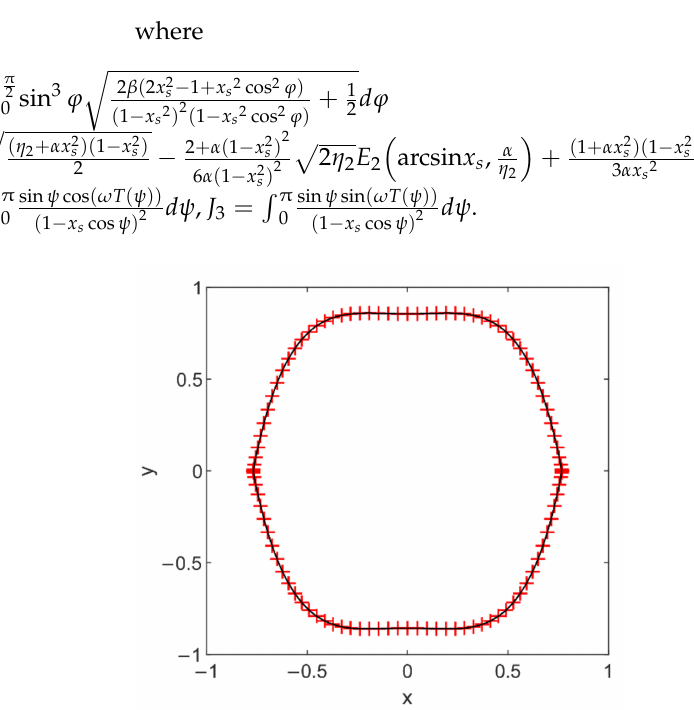
Figure 6. Comparison of heteroclinic orbits of the system (6) where the solid curve represents the exact model based on Hamiltonian and the sign + shows the orbits in explicit functions of ψ